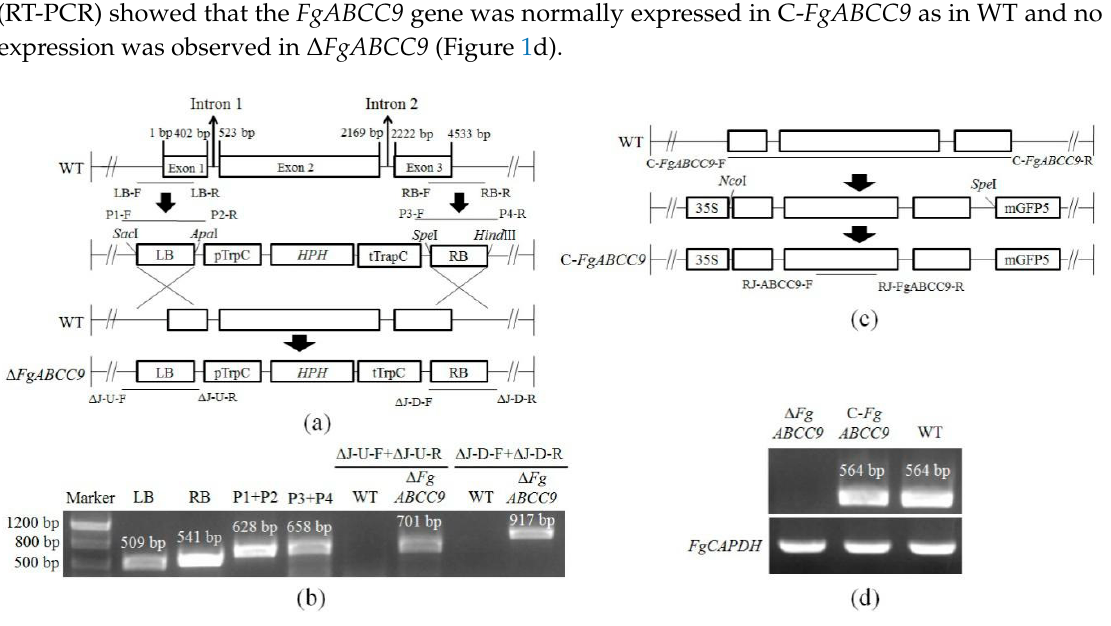
Figure 1. Construction of deletion and complementation mutants for FgABCC9 . ( a ) The left border (LB) and the right border (RB) were amplified from the wild type (WT) strain to construct the recombinant plasmid. Δ FgABCC9 mutants were then created by homologous recombination between the plasmid and FgABCC9 . ( b ) PCR verification of Δ FgABCC9 . ( c ) Gene sequence of FgABCC9 was amplified from the genomic DNA of WT and ligated into the complementation vector. The T-DNA region of the complementation vector was inserted into the genome of Δ FgABCC9 to create C -FgABCC9 . Sac I, Apa I, Spe I, Hind III, Nco I, and Spe I show the restriction enzymes used. ( d ) RT (reverse transcription)-PCR of FgABCC9 in C -FgABCC9 using RJ- ABCC9 -F + RJ- ABCC9 -R. FgGAPDH was used as reference. The black lines under the elements in ( a ) and ( c ) represent the targeted location of primers listed in Table 1. LB-F + LB-R, RB-F + RB-R, C- FgABCC9 -F + C- FgABCC9 -R were located in the genomic sequence of FgABCC9 of the WT strain. P1-F + P2-R and P3-F + P4-R were mapped in the T-DNA fragment of the pRF-HU2 vector. ∆ J-U-F, ∆ J-U-R, ∆ J-D-F, and ∆ J-D-R were, respectively, positioned into the